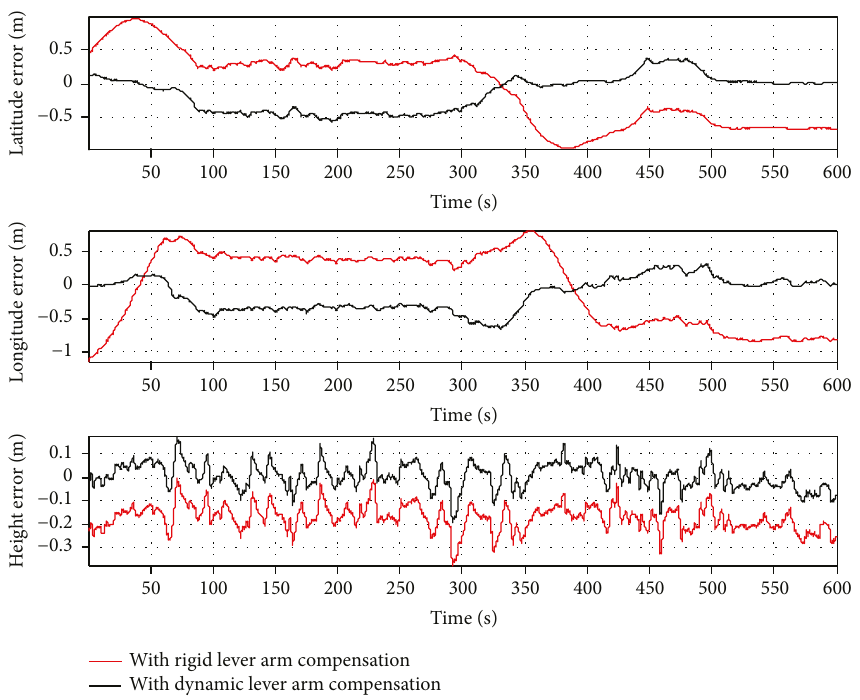
Figure 11: Position error comparison of the second-level dynamic lever arm error